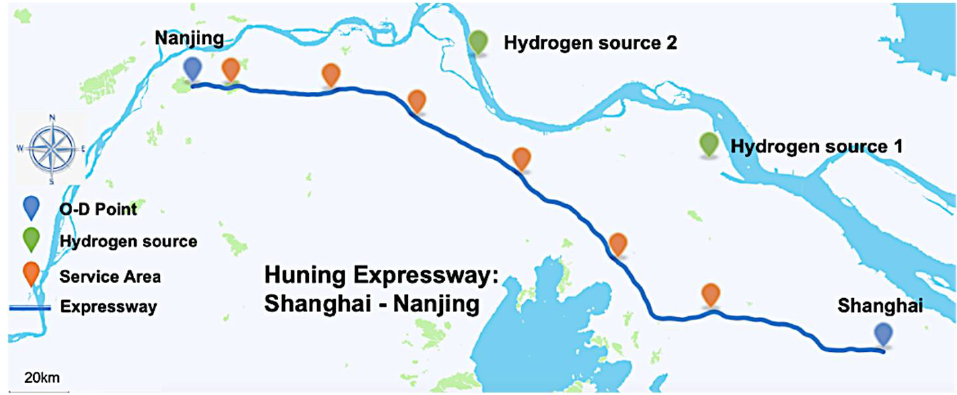
Figure 3. Schematic of expressway and service area and hydrogen source distribution. (Note: This map is made based on the standard MAP GS (2021) 6375 of AmAP, and the base map is not modified).